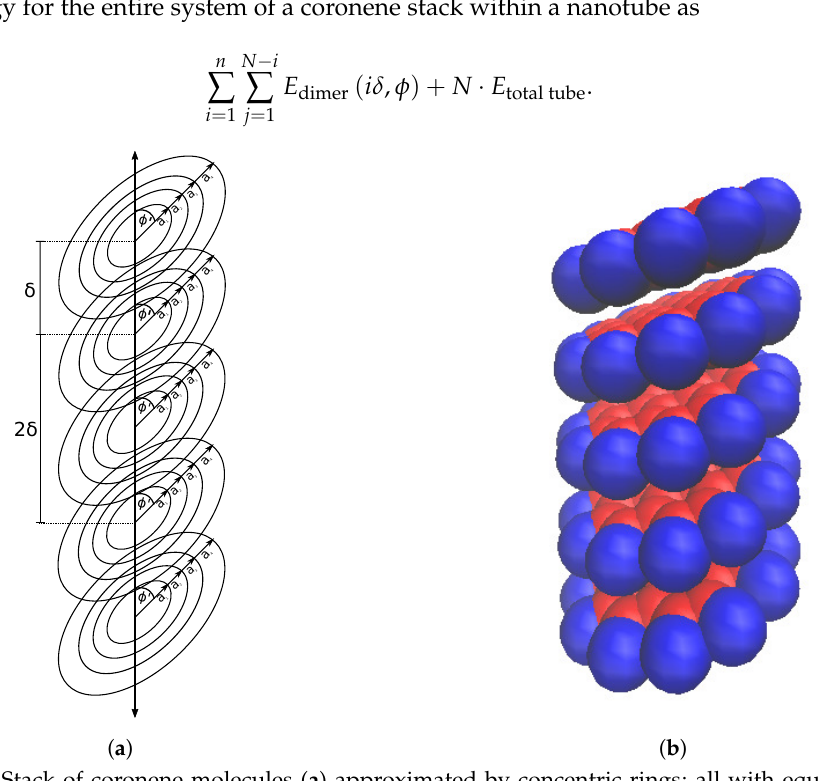
Figure 6. Stack of coronene molecules ( a ) approximated by concentric rings; all with equidistant placing along axis by distance δ and all tilted by the same angle φ (cid:48) = π /2 − φ and ( b ) represented by space filling